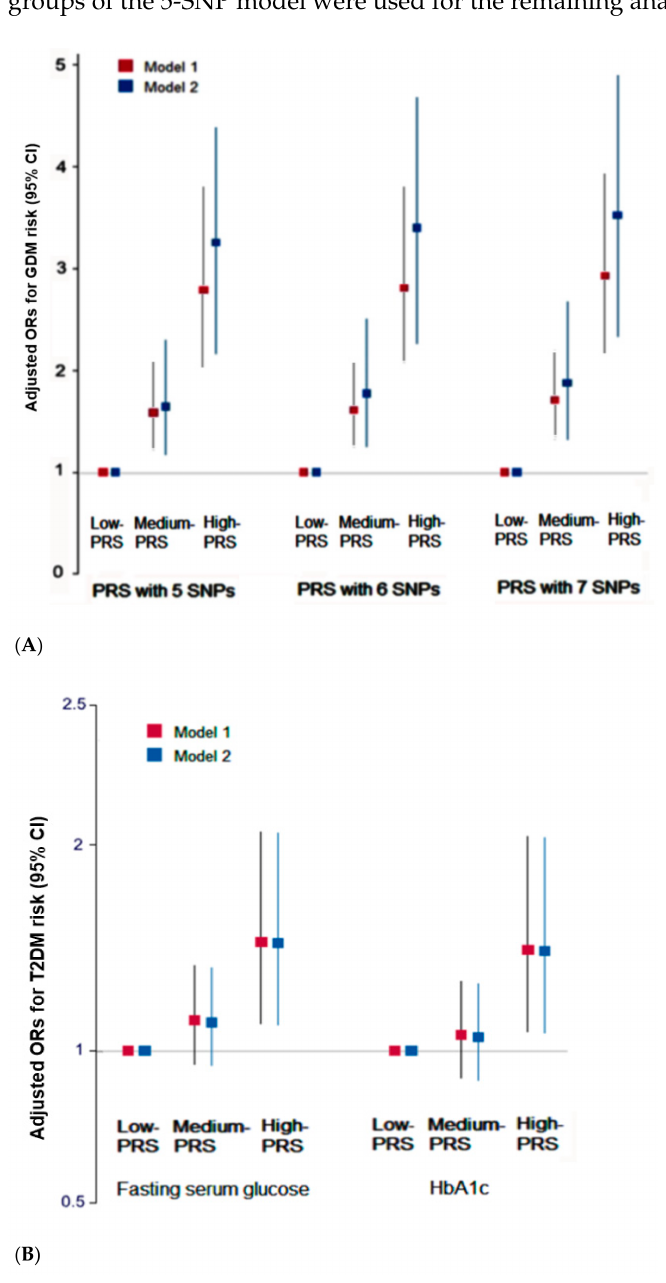
Figure 3. Adjusted odds ratio (ORs) for GDM or type 2 diabetes (T2DM) risk according to the groups of the low, medium, or high polygenetic risk scores (PRS) of the 5-, 6-, or 7-SNP models from GDM risk ( A ). Adjusted ORs and 95% confidence intervals (CI) for GDM according to the PRS groups of the 5-, 6-, or 7-SNP models from GDM risk. ( B ) Adjusted ORs and 95% confidence intervals (CI) for T2DM according to the PRS groups of the 5-, 6-, or 7-SNP models from GDM risk. The PRS of the 5-SNP model for GDM risk was positively associated with the fasting serum glucose concentrations and HbA1c contents by 1.55 (1.15–2.08) and 1.48 (1.09–2.03) times, respectively (Figure 3B). On the other hand, the PRS was not associated with